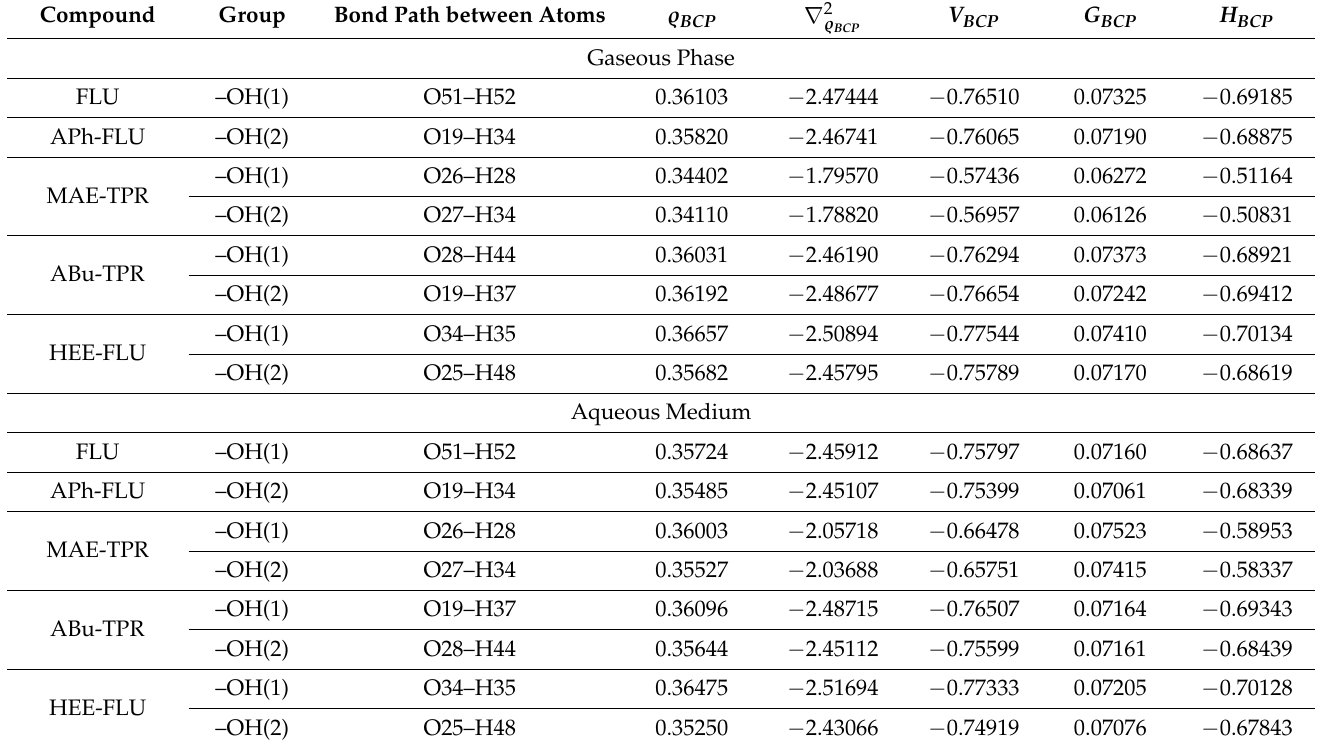
Table 2. Calculated parameters (in atomic units) in gaseous and aqueous phases for the critical point of the bond path between hydrogen and oxygen atoms in the hydroxyl group: electron density ( (cid:36) BCP ), Laplacian of electron density ( ∇ 2 (cid:36)